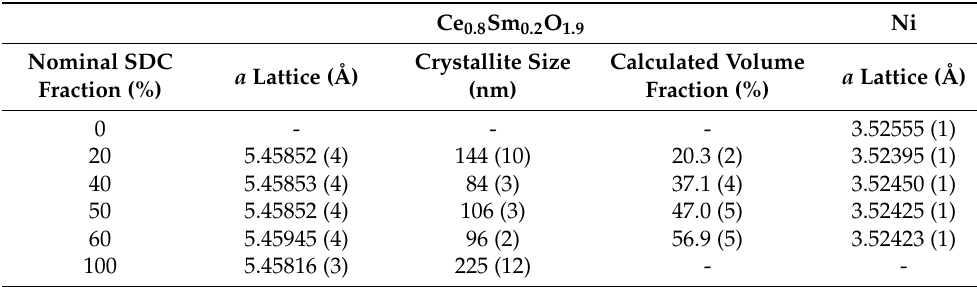
Table 3. Relevant crystal structure parameters of various phases in composite materials. Estimated standard deviations are given in parentheses.